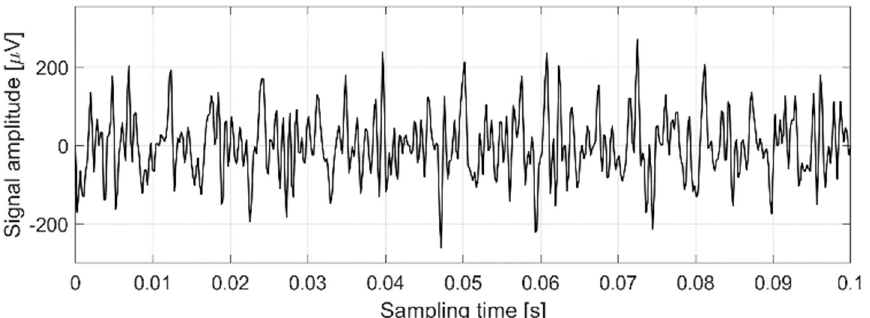
Figure 2. Single pixel signal time evolution .